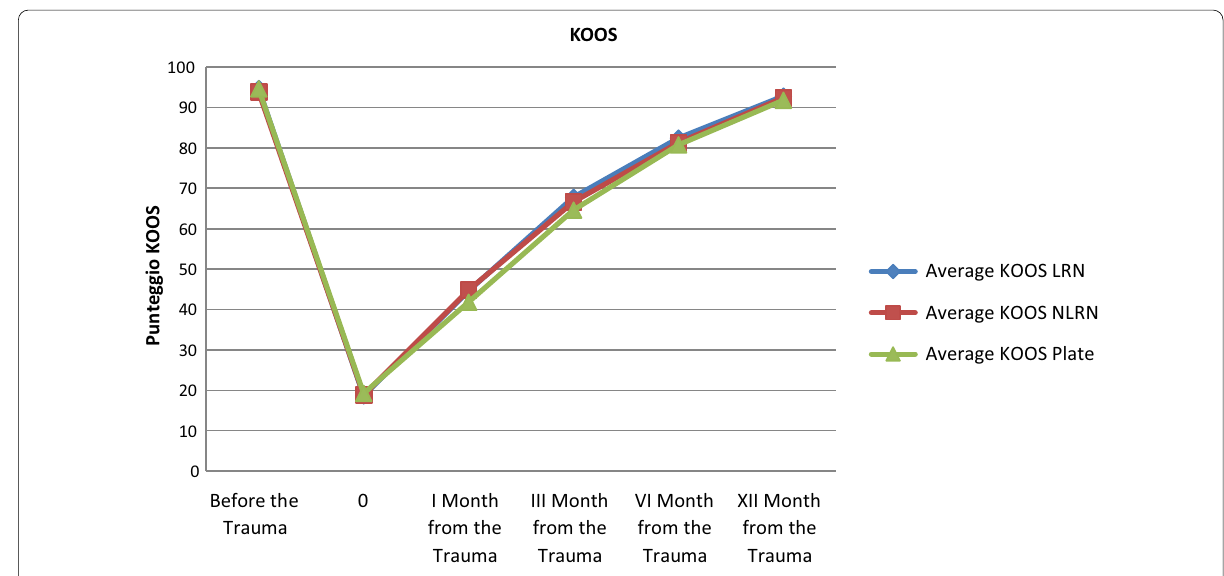
Fig. 1 KOOS in the three groups. No statistically significant difference at the endpoint